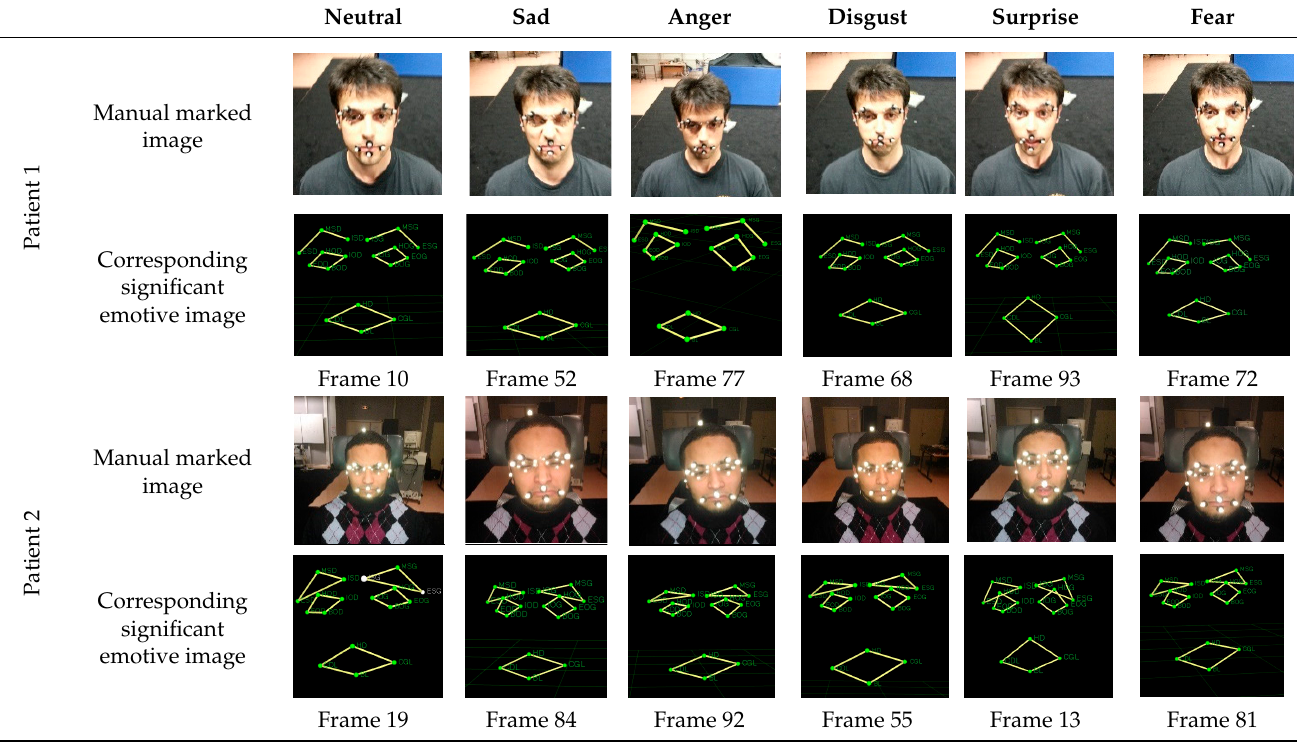
Table 2. Emotion appreciation via Qualisys system (QTM) for significant emotive image extraction.